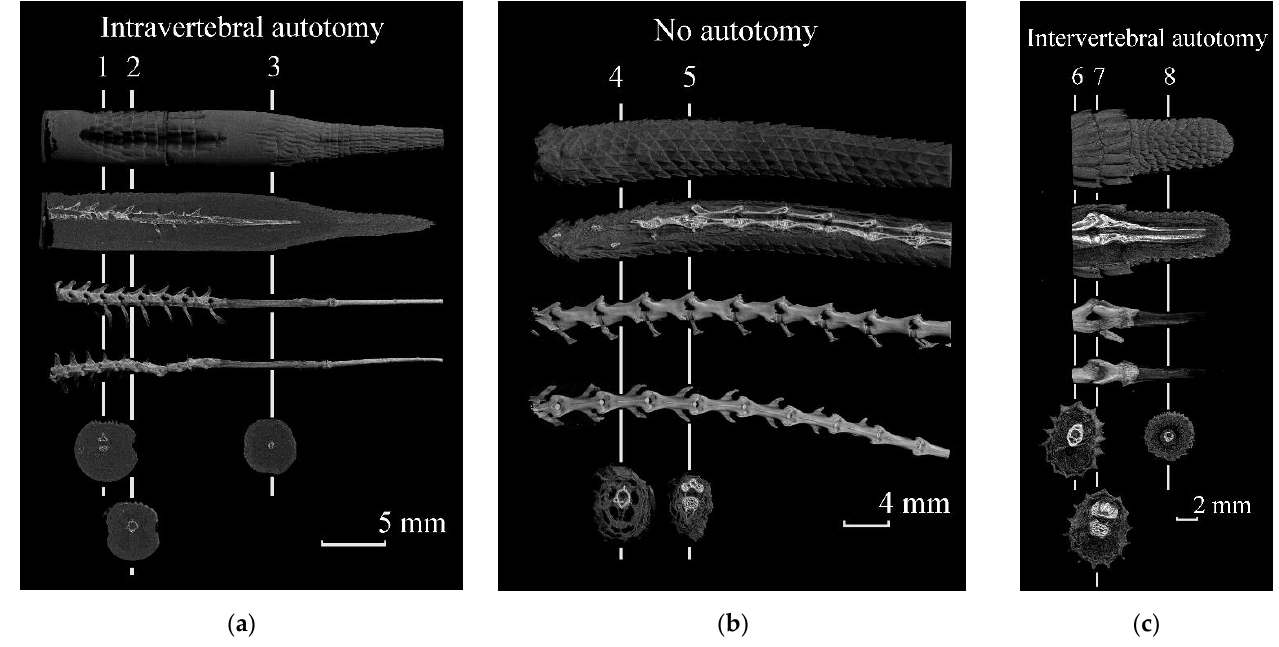
Figure 2. Three-dimensional micro-CT reconstruction of the tails with different combinations of caudal autotomy and regeneration: ( a ) the tail of Lacerta agilis (ZISP 31549) with intravertebral autotomy and regeneration—1. section between two intact vertebrae; 2. section through the cartilaginous area dividing the vertebra into two parts and serving as the plane of autotomy; 3. section through a calcified cartilaginous tube. ( b ) the structure of the intact tail of Trapelus sanguinolentus (ZISP 31548), incapable of tail ejection—4. section through the middle of the intact tail; 5. section between two intact vertebrae. ( c ) tail of Paralaudakia caucasia (ZMMSU 15396) with intervertebral autotomy and regeneration—6. section through the distal region of the intact vertebra; 7. section between two vertebrae, more than half of the second vertebra preceding the plane of autotomy, underwent ablation; 8. section through a calcified cartilage tube. The figure shows (from top to bottom): 3D reconstruction of the tail, scales covering the regenerate are much smaller in size, irregular in shape and in an irregular arrangement; a cut through the sagittal plane, showing the internal structure of the vertebrae and cartilaginous tube, the location of the muscles; 3D reconstruction of the tail vertebrae in the sagittal strip, showing differences in the structure of the intact region of the tail and regenerate; 3D reconstruction of the caudal vertebrae in the frontal plane; slices in the segmental plane. The white vertical lines show the areas of the slices in the segmental plane.